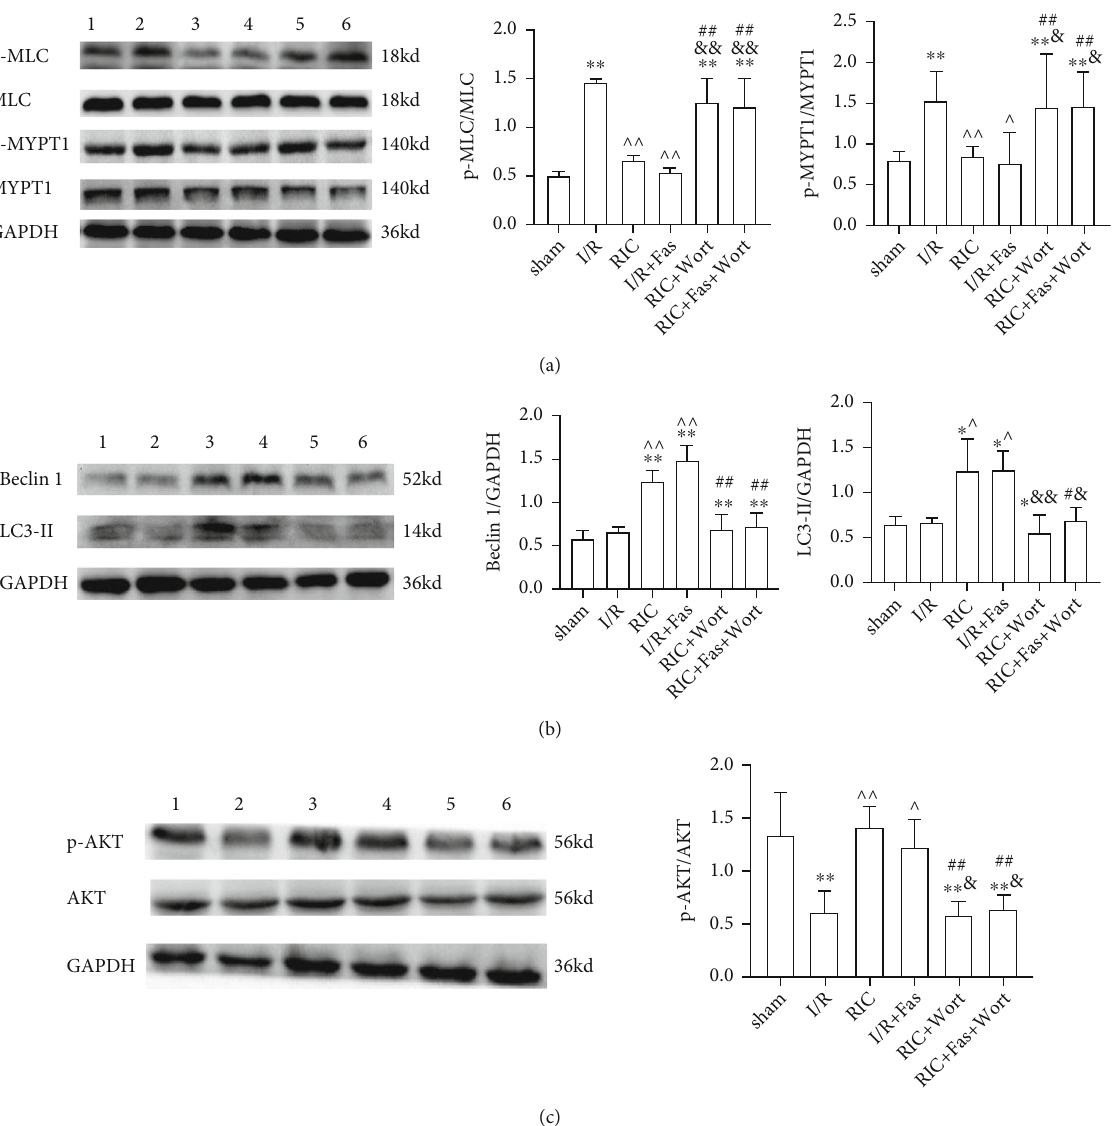
Figure 6: The protein expression and the ratio of p-MLC and p-MYPT1 (a), Beclin 1 and LC3-II (b), and p-AKT (c) in the myocardium in the di ff erent groups. Lane 1: sham group; lane 2, I/R group; lane 3, RIC group; lane 4, I/R+Fas group; lane 5, RIC+Wort group; lane 6, RIC+Fas +Wort group. Data are presented as the mean ± SD ( n = 4 ). ∗ P < 0 : 05 vs. sham group; ∗∗ P < 0 : 01 vs. sham group; # P < 0 : 05 vs. RIC group;